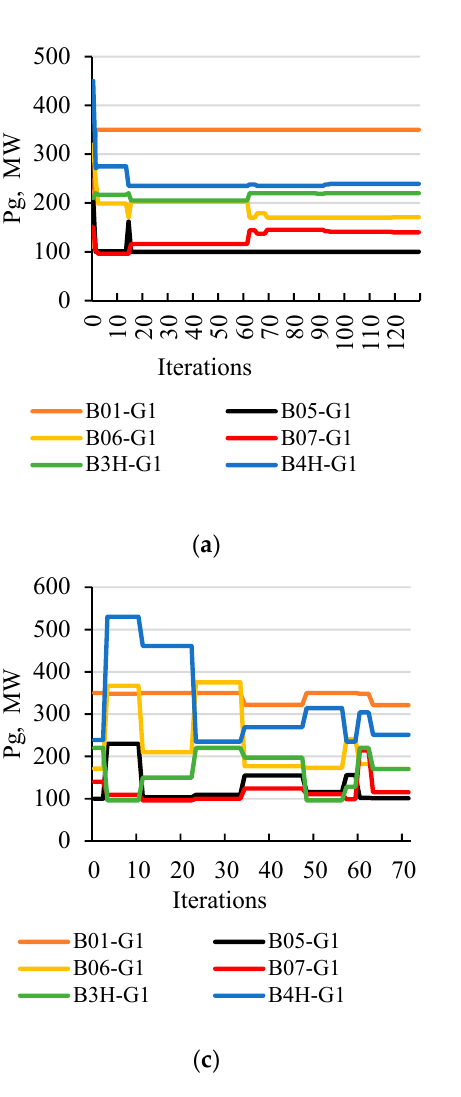
Figure 9. The process of determining the maximum SPA for case 4; ( a ) changing the generation distribution to determine the maximum (global) SPA; ( b ) a graph of changes in the value of the objective function (maximum SPA); ( c ) changing the generation distribution to determine a maximum safe SPA; ( d ) graph of changes in the value of the objective function with the penalty function (maximum safe SPA). Table 6. List of sources with optimal capacity and expected values of power surges calculated for each generator.